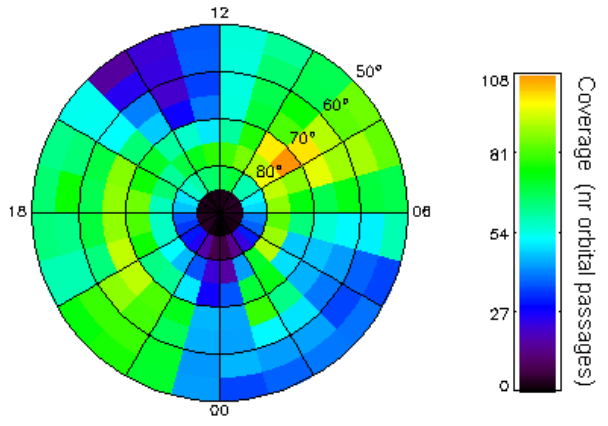
Fig. 1. Orbital coverage corresponding to the data set used in this